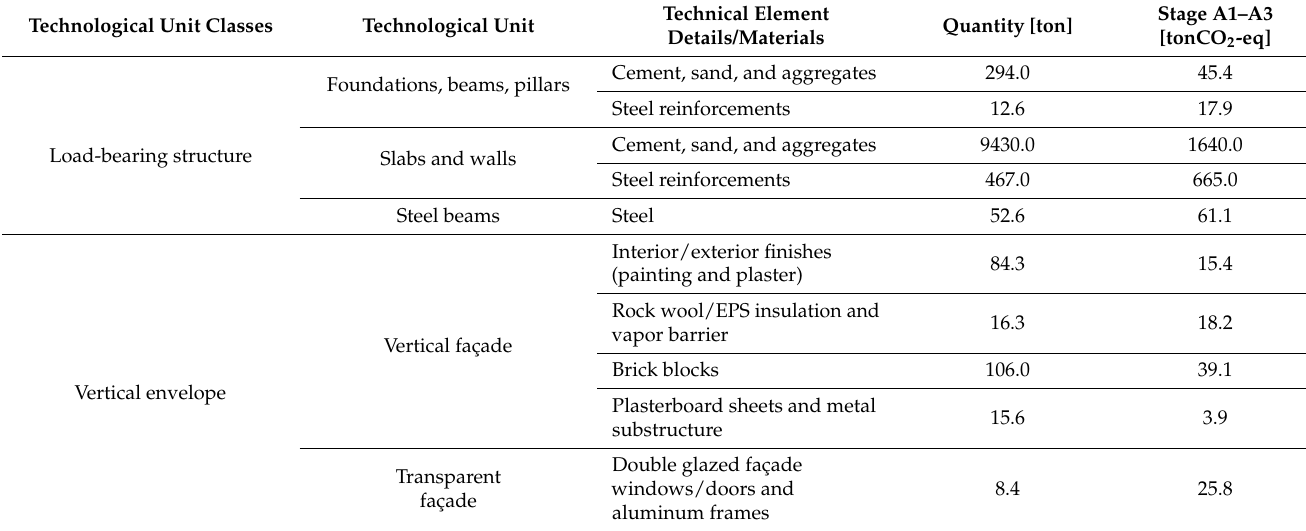
Table A4. Material construction phase impacts (A1–A3) for the nZEB